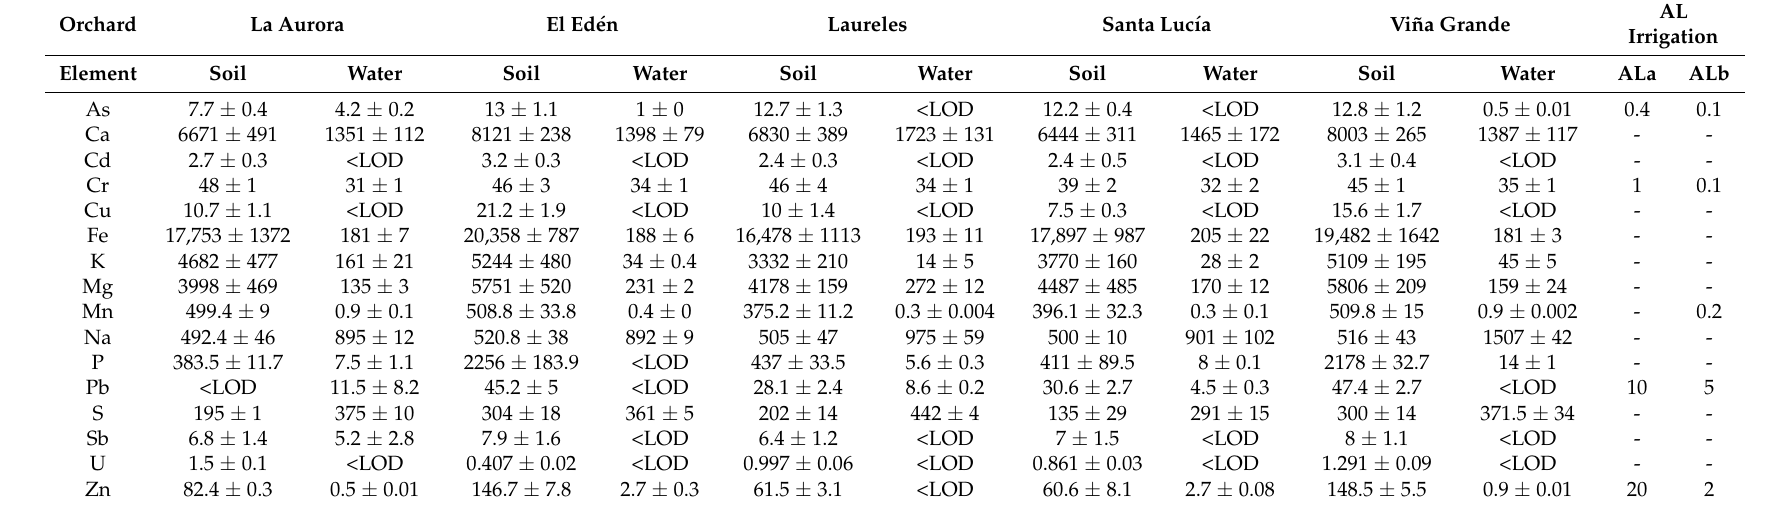
Table 2. Averages of elemental content ( µ g/g) in soil and irrigation water, as well as their